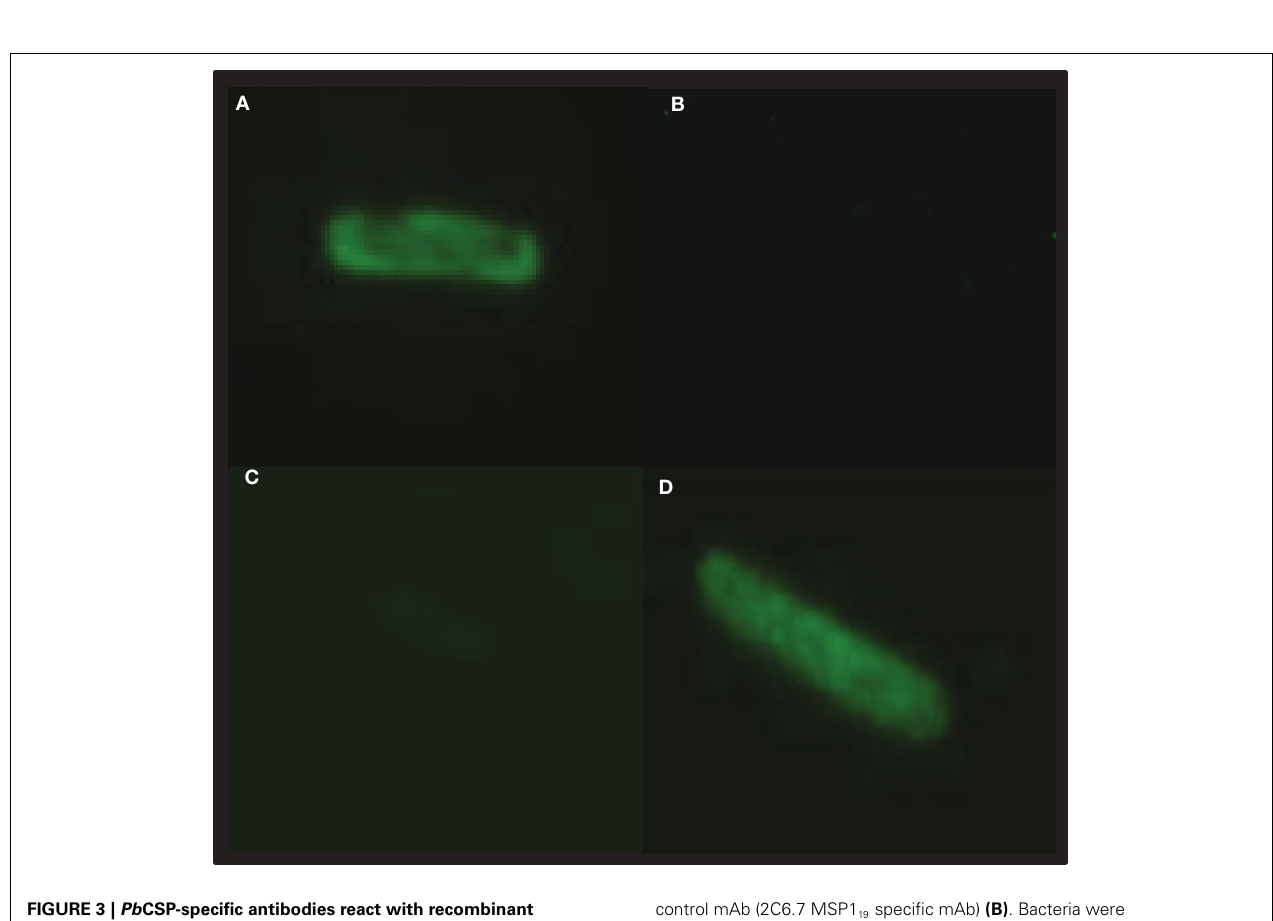
FIGURE 3 | Pb CSP-specific antibodies react with recombinant expressing Pb CSP GeMI-Vax bacteria . Bacteria expressing Pb CSP in the outer membrane (A,B) or periplasmic space (C,D) were stained with the Pb CSP-specific mAb 4B10 (A,C,D) or